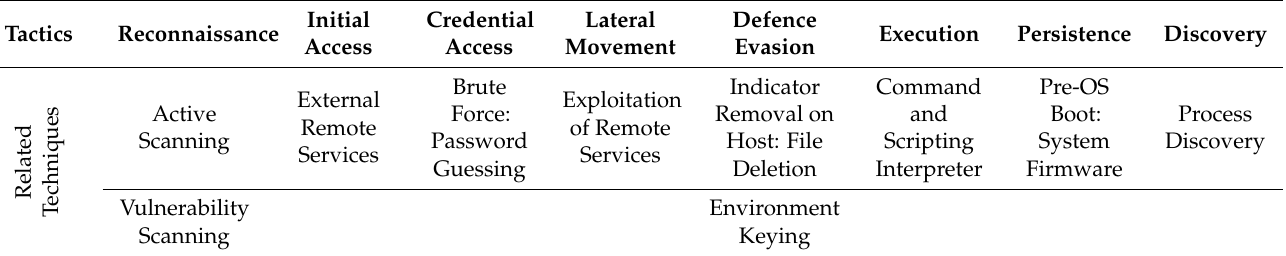
Table 13. IoT botnet early-stage detection framework based on MITRE